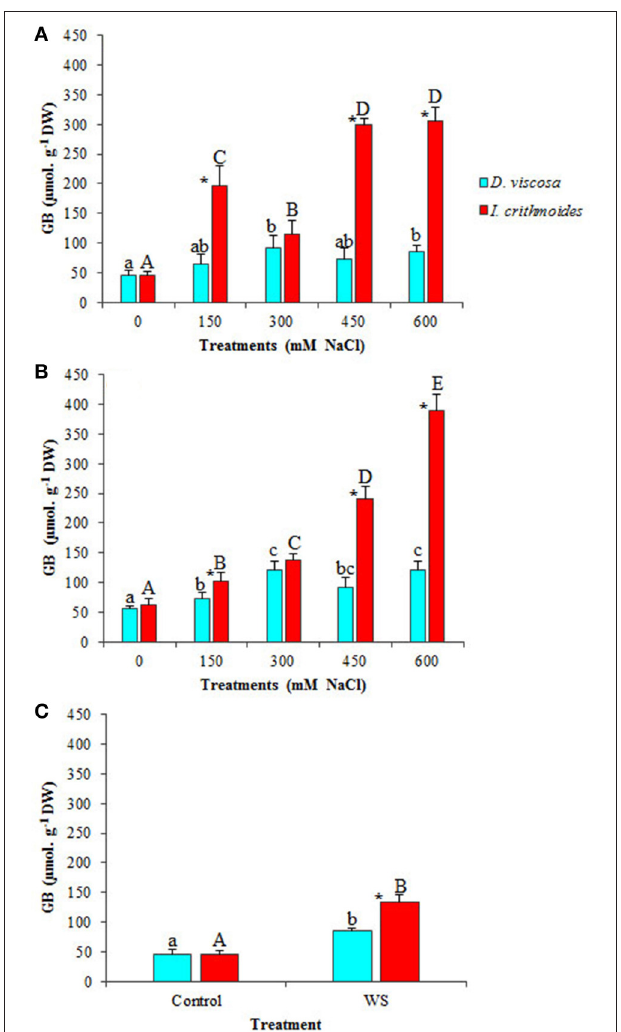
FIGURE 4 | Glycine betaine (GB) accumulation in leaves of D. viscosa and I. crithmoides stressed plants. GB contents after 3 weeks (A) and 6 weeks (B) of treatment with the indicated NaCl concentrations, or after 3 weeks of water stress (C) . Values shown are means ± SD ( n = 5 ). Different letters (lowercase for D. viscosa and capital letters for I. crithmoides ) over the bars indicate significant differences between treatments for each species according to Tukey test ( α = 0.05). Asterisks ( * ) indicate significant differences between the two species for the same